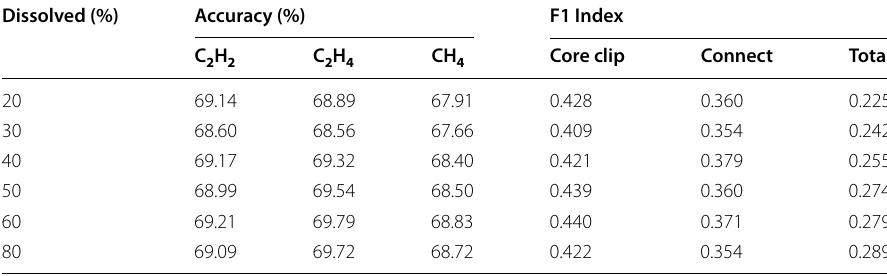
Table 7 The composition and content of dissolved gases in transformer oil and